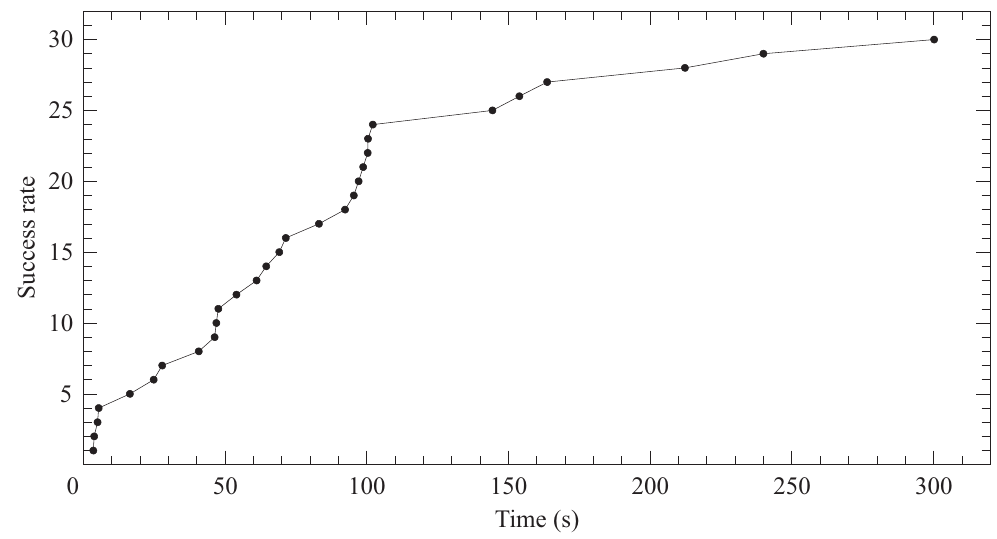
Figure 6. Number of runs where the best solution was found by SA-VNS-1-1 versus the computation time (in seconds) for